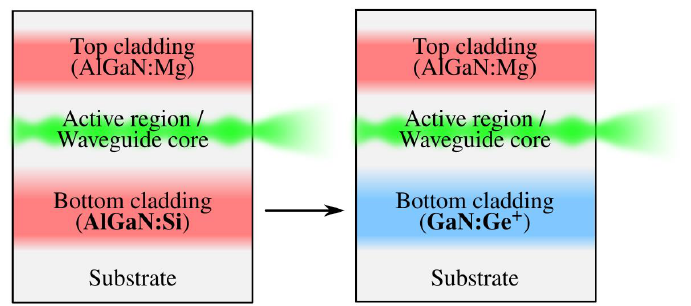
Figure 1. We aim at replacing the lower silicon-doped AlGaN cladding layer of the classic laser-diode structure with a heavily germanium-doped GaN